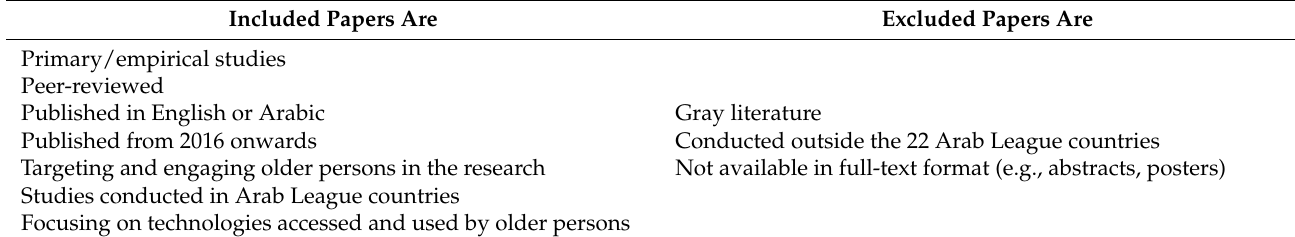
Table 1. Inclusion and exclusion